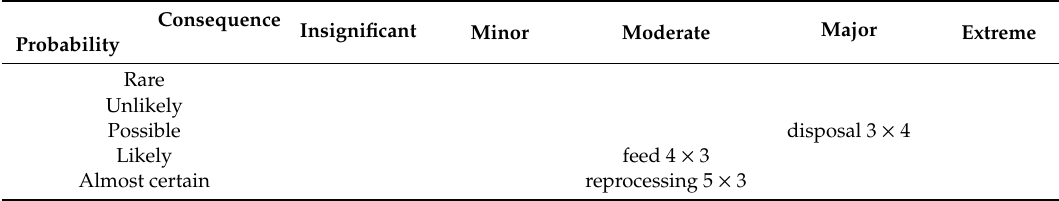
Table 7. Consequence / probability matrix.